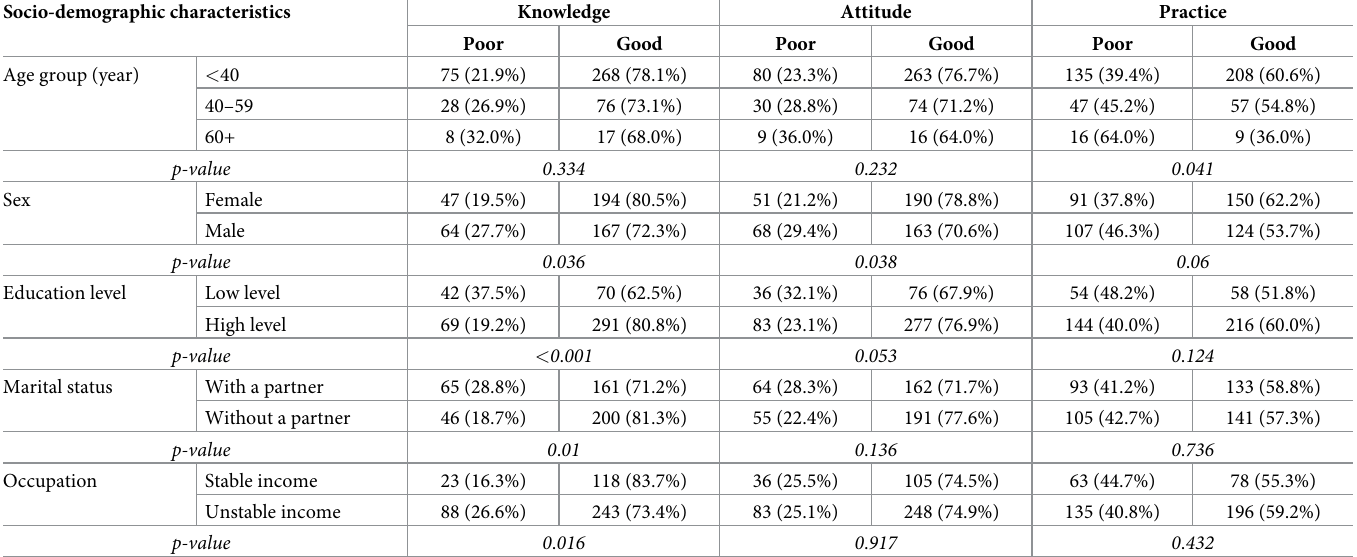
Table 4. Univariate analysis of factors associated with knowledge, attitudes, and practices related to COVID-19. Socio-demographic